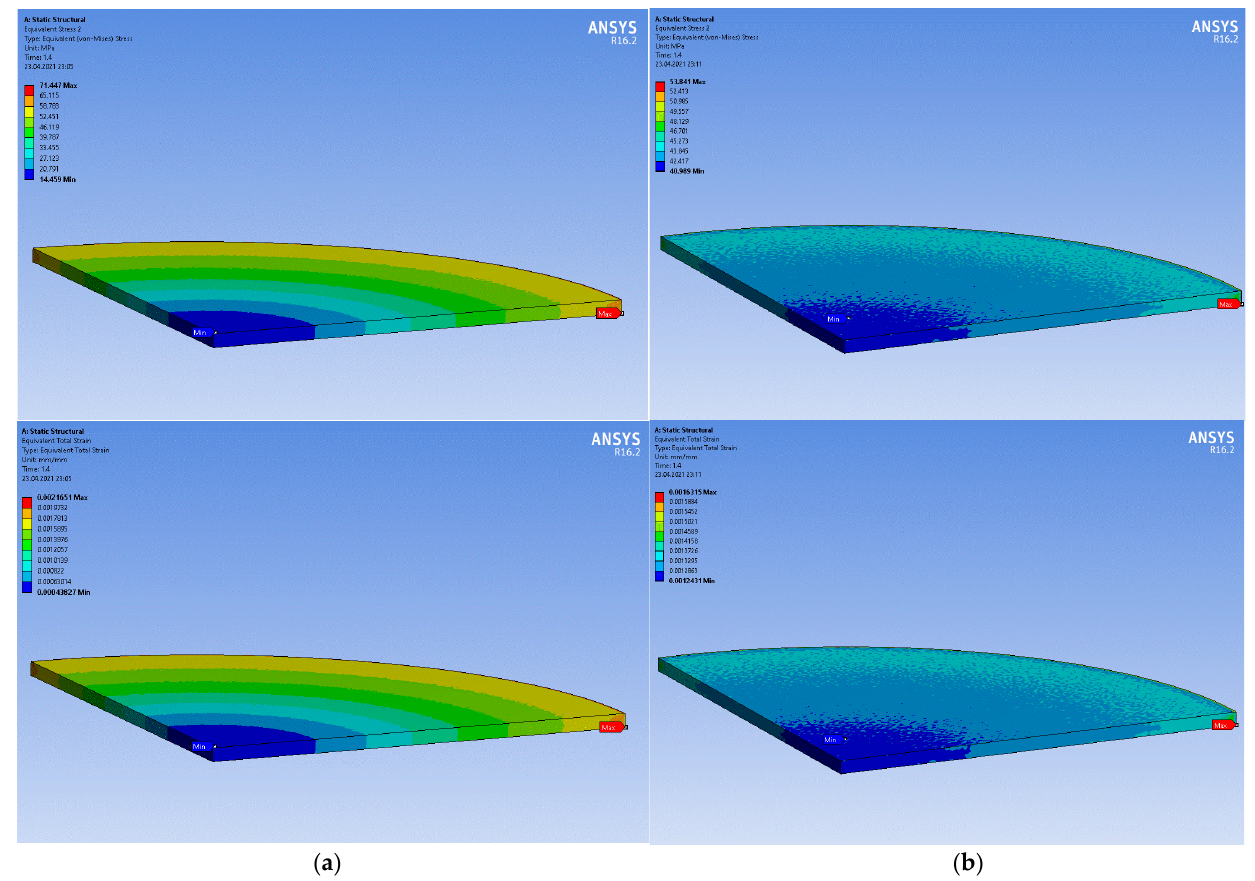
Figure 8. Equivalent stress distribution and total strain at the debonding area of the Al 2 O 3 coating with a tensile force of F = 14,000 N: ( a ) ASTM C633-79 (2021) standard specimen, type 3; ( b ) Elongated specimen, type 6. For geometric parameters, see Figure 2.